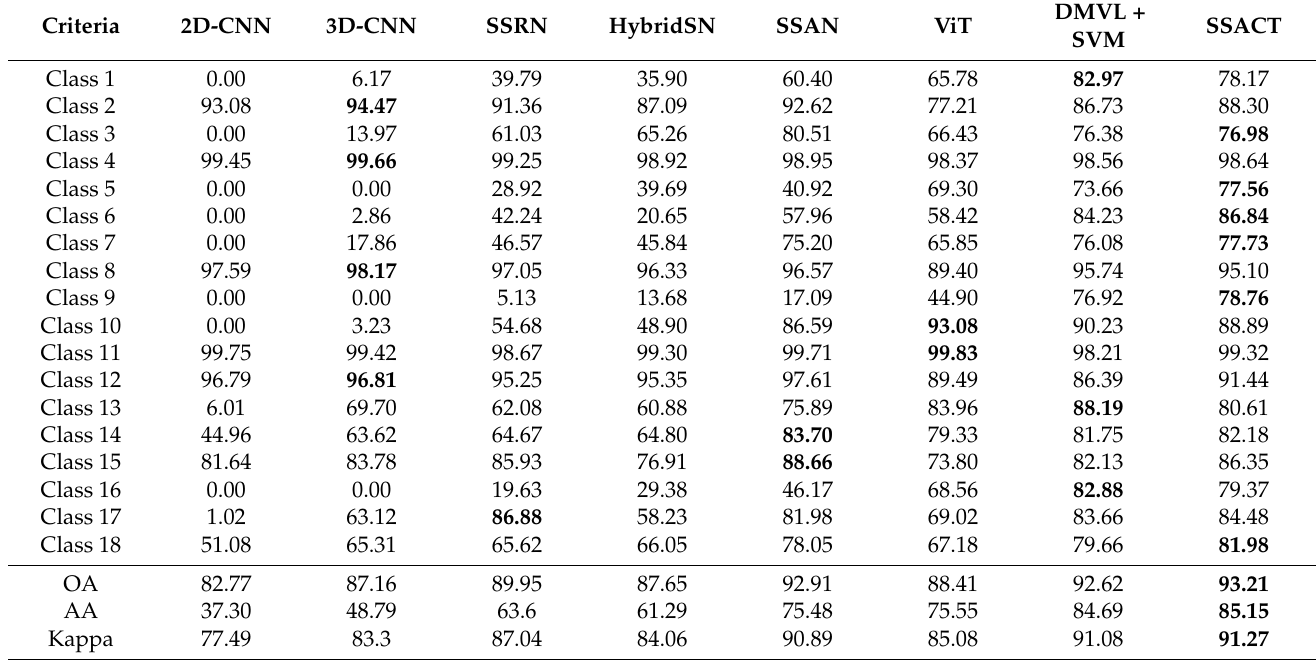
Table 4. Classification results (%) by selecting 10% labeled samples of the GF14